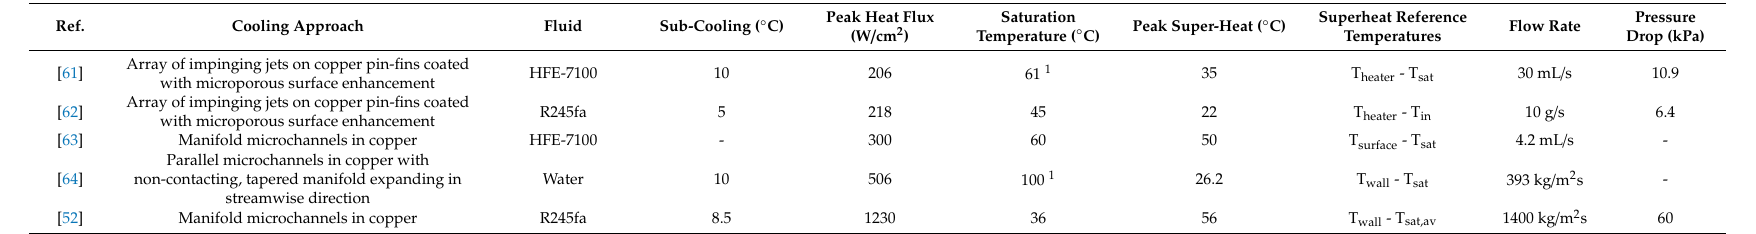
Table 1. High heat flux chip-scale two-phase cooling approaches in